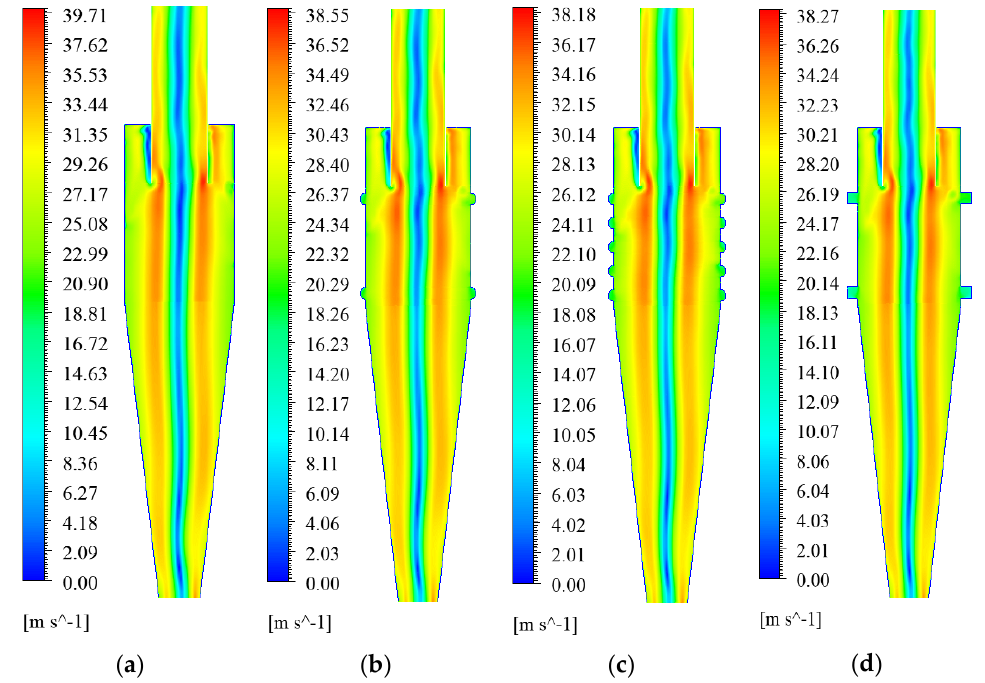
Figure 9. Contour plots of velocity magnitude of cyclone models; ( a ) Model A (Stairmand cyclone separator), ( b ) Model B cyclone separator, ( c ) Model C cyclone separator, ( d ) Model D cyclone separator.